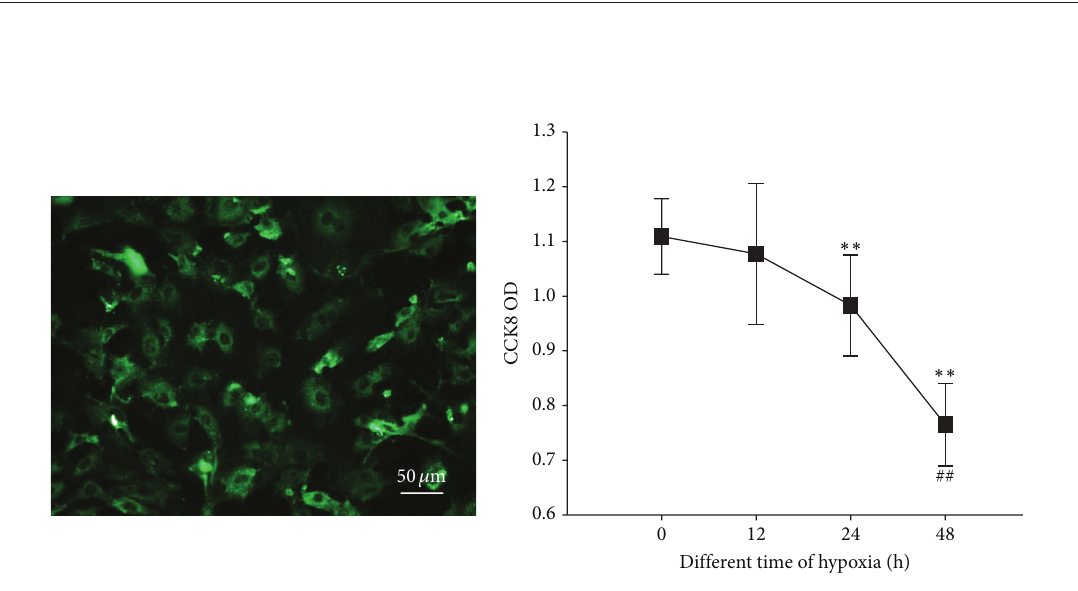
Figure 1: Vimentin staining and vitality of CFs under hypoxia. (a) CFs with vimentin marker was identified by green immunofluorescence. (b) Cell vitality curve depicted using time points of 0 h, 12 h, 24 h, and 48 h under hypoxia. Cell vitality dropped in a timely dependent manner. Results are shown as the mean ± SD values. Experiments were repeated three times. ∗∗ indicates 𝑃 < 0.01 compared to the 0h group. ## indicates 𝑃 < 0.01 compared to the 24 h